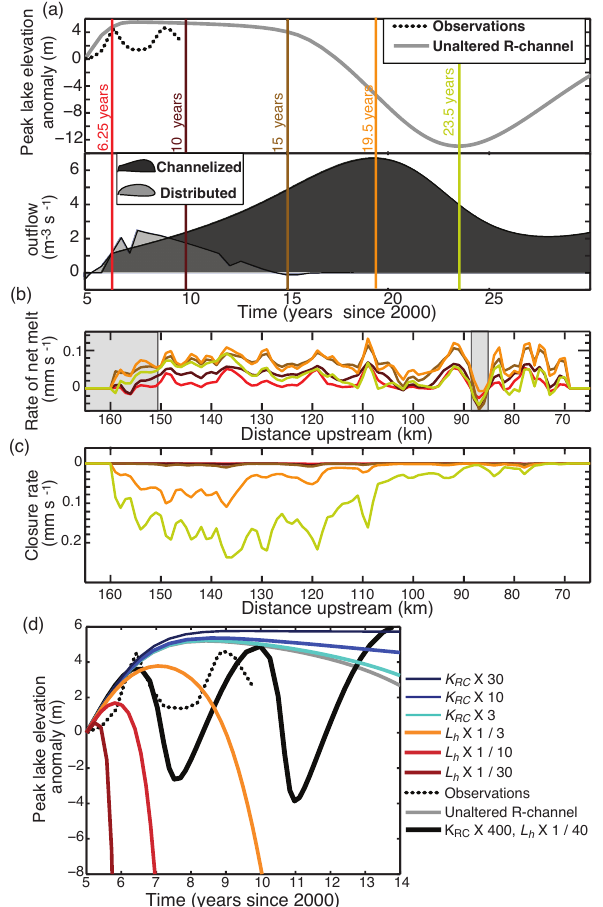
Figure 5. Results of experiments with R-channel model on the SLW domain (see Fig. 1b for location and Fig. 4b for flow path geome- try). (a) Modeled lake elevation anomaly and outflow obtained for the channelized and distributed drainage systems; observed lake el- evations (Carter et al., 2013) are also shown. (b) Net melt rate along the flow path for five time steps shown in (a) , with gray boxes denot- ing areas of net freezing; (c) viscous closure rate ( C VRC ). (d) Mod- eled lake elevation anomalies resulting from varying parameters controlling channel closure ( K RC ) and opening ( L h